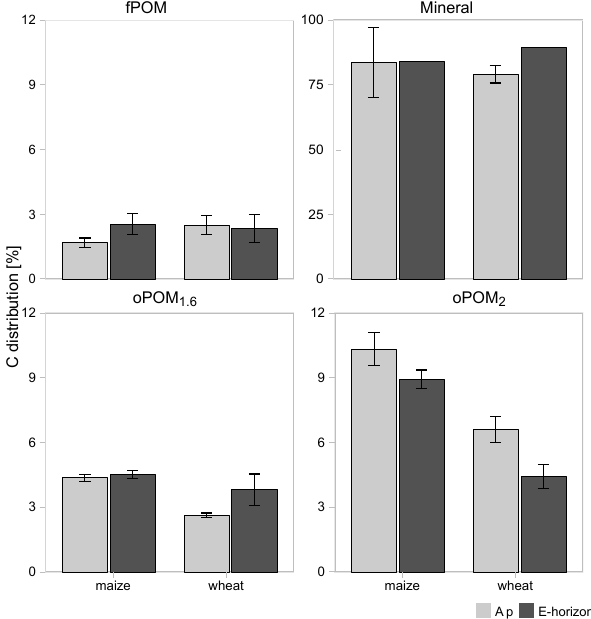
Figure 1. Organic carbon distribution in the investigated density fractions. Means and standard error ( n =